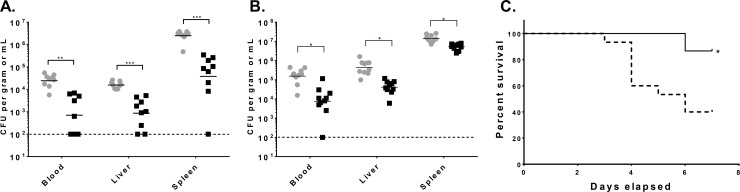
Protective efficacy of passively transferred conjugate-induced antibodies against systemic KP infection in mice.(A,B) Naïve mice were passively administered IP pooled pre-immune (grey circles) or conjugate-induced (black squares) antisera followed by intravenous infection with KP O1 strain B5055 (n = 9/group) (A), or KP O3 strain 700603 (n = 10/group) (B). Mice were euthanized 4 hours after inoculation, and viable colony counts were determine in the blood, liver and spleen as indicated. Statistical significance for post-immune compared to pre- immune sera by Mann-Whitney are shown. Each point represents an individual mouse. Bar = geometric mean. (C) Naïve mice (15/group) were passively administered pre-immune (dash line) or conjugate-induced (solid line) rabbit sera and then assessed for mortality after intravenous infection with KP B5055. Results are the combination of two independent experiments. P value by log-rank test for pre-immune compared to immune sera is indicated. * P ≤ 0.05, ** P≤ 0.001, *** P ≤ 0.0001.